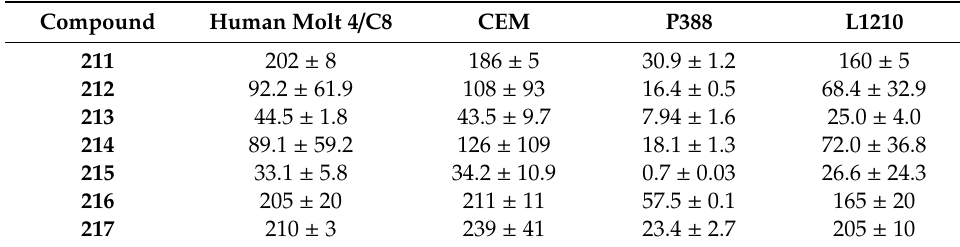
Table 31. IC 50 values ( µ M) of compounds 211 – 217 for human Molt 4 / C8, CEM T-lymphocytes, murine P388, and L1210 cells.